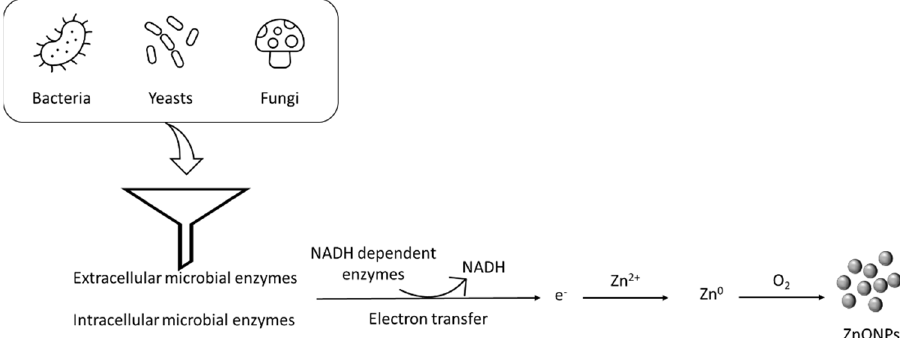
Figure 6. Role of NADH and NADH-dependent microbial enzymes in the synthesis of ZnONPs. Adapted from [107] with permission from Elsevier.